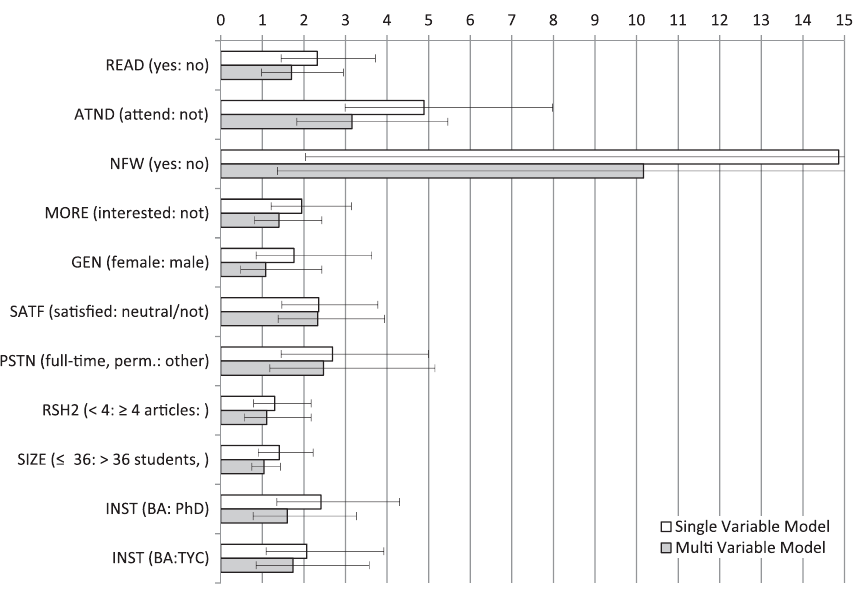
FIG. 2. Odds ratios and 95% confidence intervals for knowledge versus no-knowledge groups. The 95% confidence intervals for the NFW variable extend off the chart. A confidence interval that includes ‘‘1’’ suggests that the groups are not significantly different.